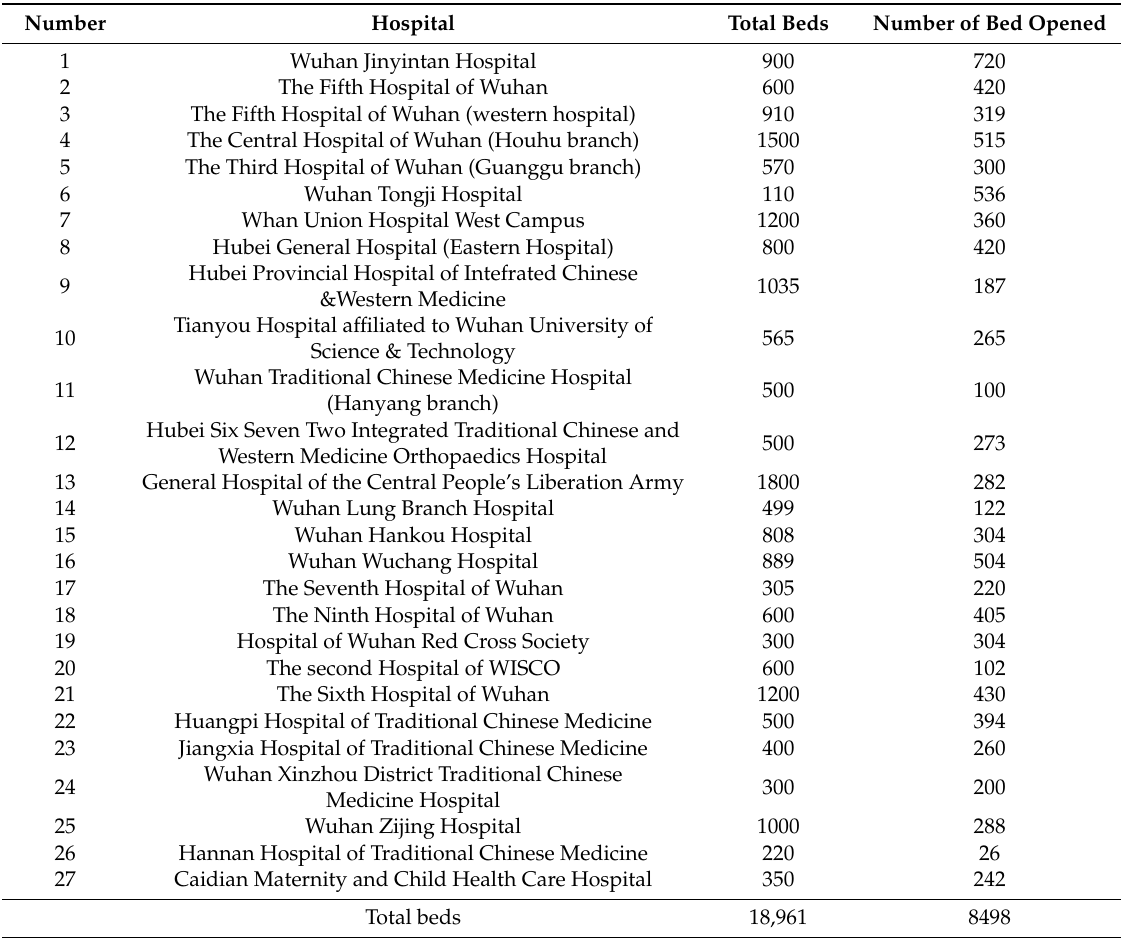
Table A1. Names, totalbeds, andnumberofbedsopenedatexistinghospitalsfortheCOVID-19infections.